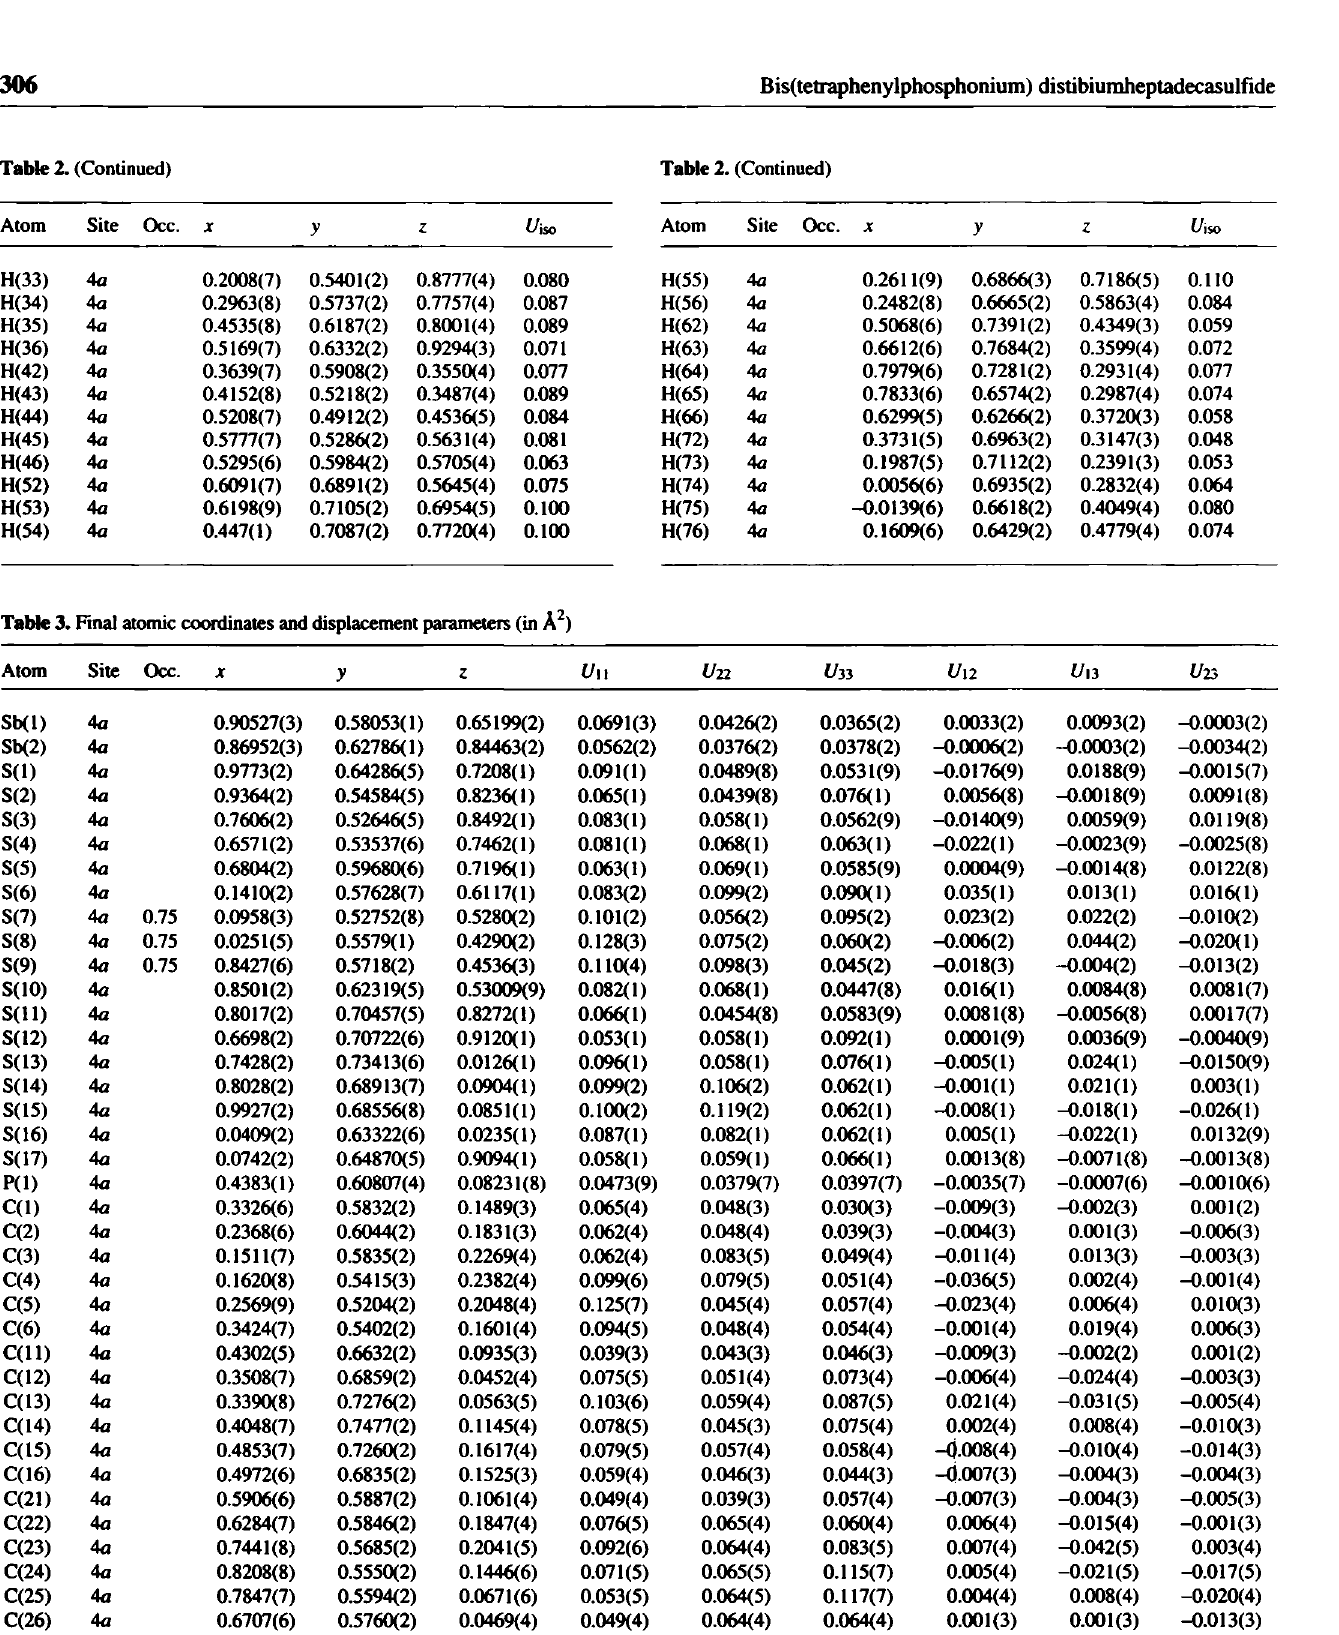
Table 3. Final atomic coordinates and displacement parameters (in Â 2 ) Atom Site